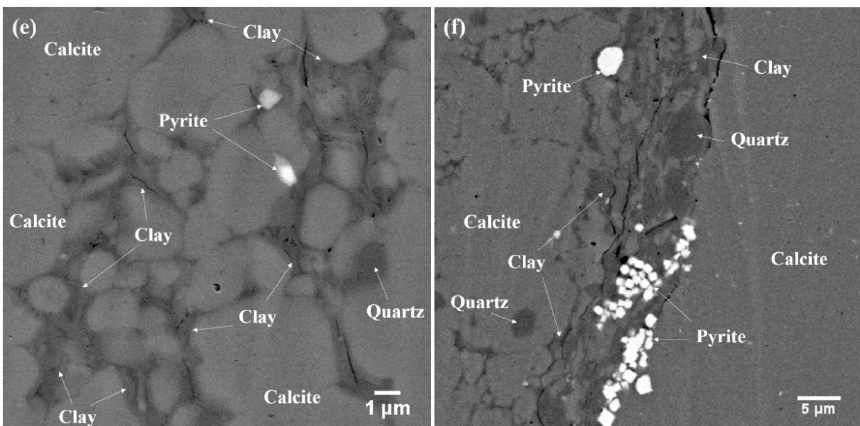
Figure 6. BSE images of Cobourg limestone. ( a ) Angular intraparticle pores with sizes up to a few micrometers in calcite